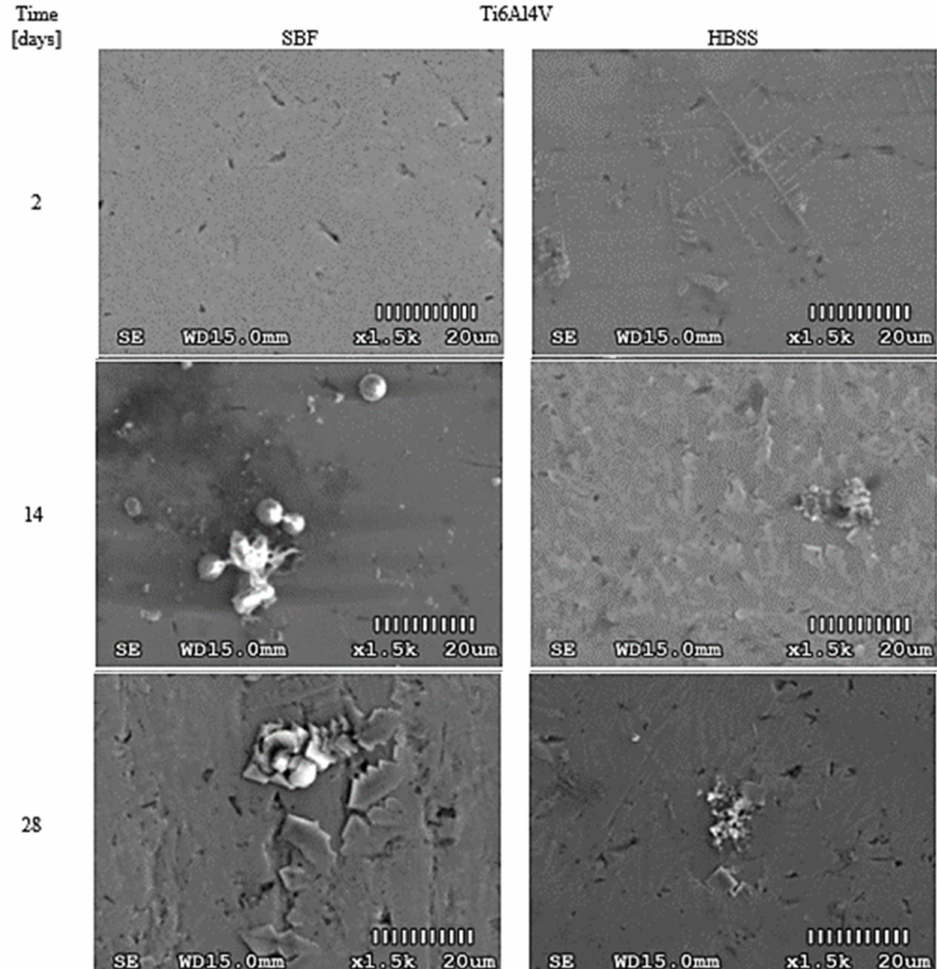
Figure 4. Morphological changes on the surface of Ti6Al4V immersed in SBF and HBSS after selected time